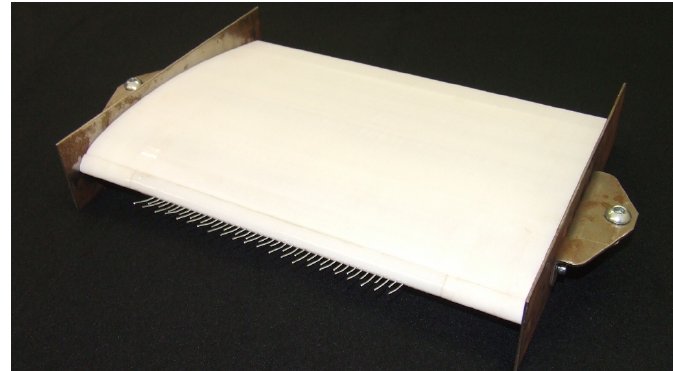
Figure 5. Photograph of the airfoil used for the present investigation (with curved teeth of 12 mm and 20 mm